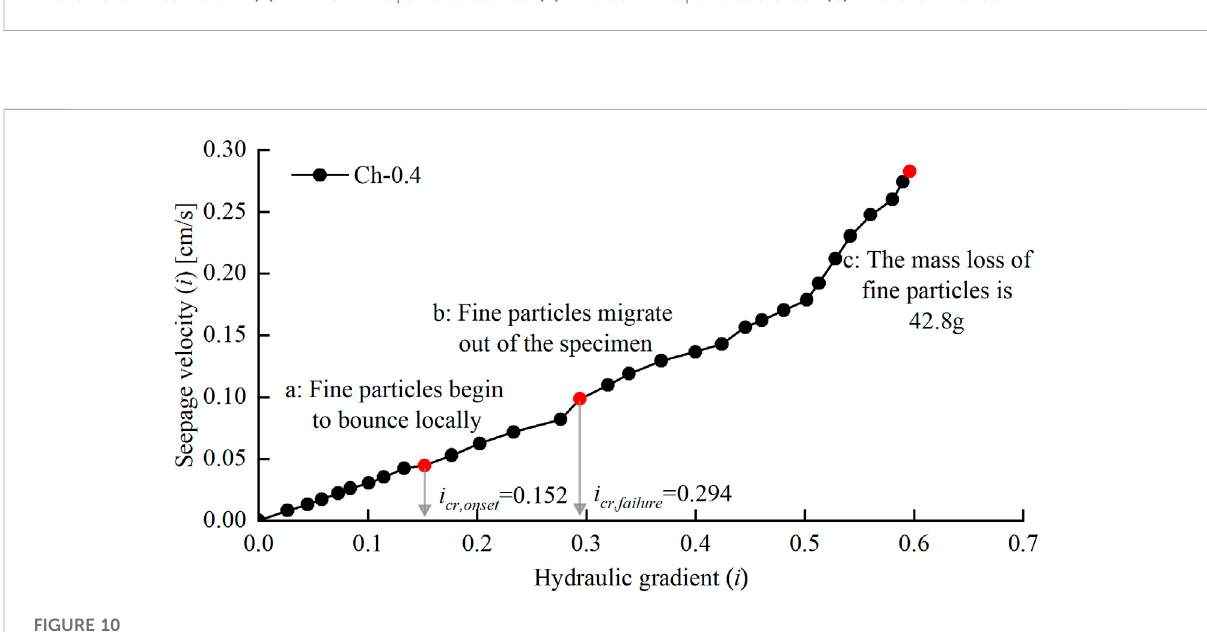
FIGURE 10 i – v curve for test Ch-0.4.